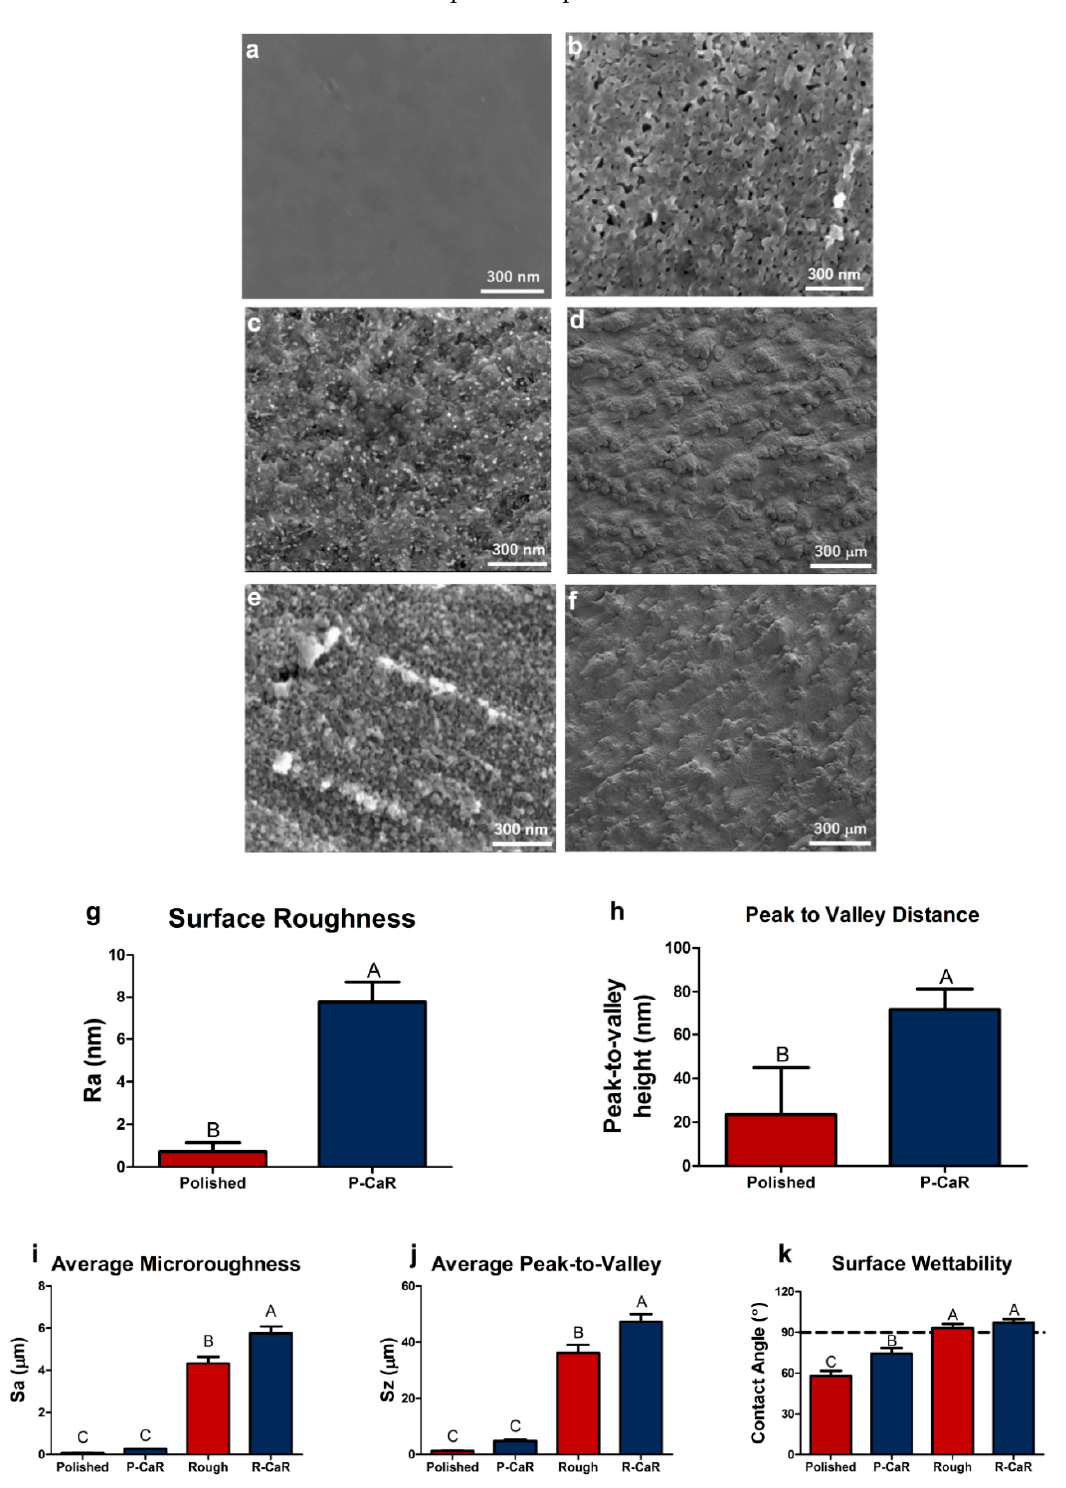
Figure 6. Characterization of the surface topography of polished and microrough (grit-blasted, acid-etched) DMLS TiAl6V4 specimens before and after the reaction process: ( a ) SE image of a starting polished specimen, ( b ) SE image of a polished specimen after completion of the surface reaction process (surface oxidation, reaction with Ca(g), CaO dissolution), ( c , d ) SE images of a starting